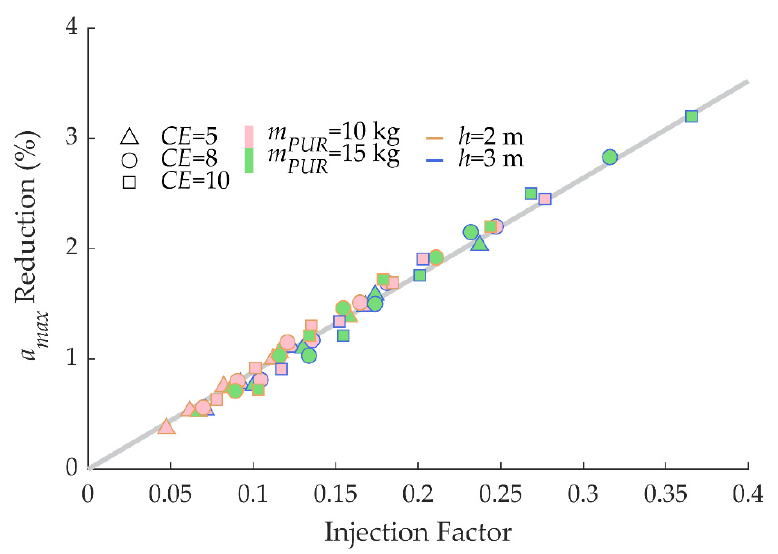
Figure 14. Reduction of surficial accelerations in relation to the injection factor, representative of the number of injections, mass of injected polyurethane, depth of injected soil, as well as the soil stiffness.